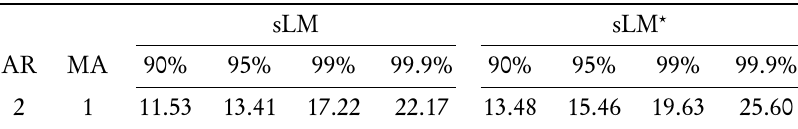
Critical values for the asymptotic null distribution of the sLM and sLM (cid:63) statistics when the autoregressive order and moving-average order are 2 and 1, respectively. The threshold range is [ r ] with r , r and r being the 25th and 75th percentile, L U L U